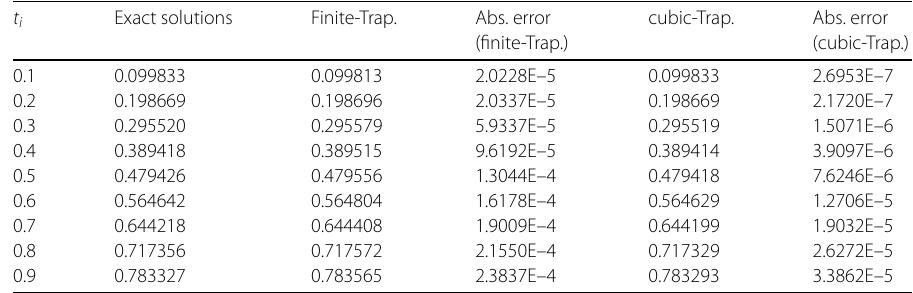
cubic-Trap. Abs. error